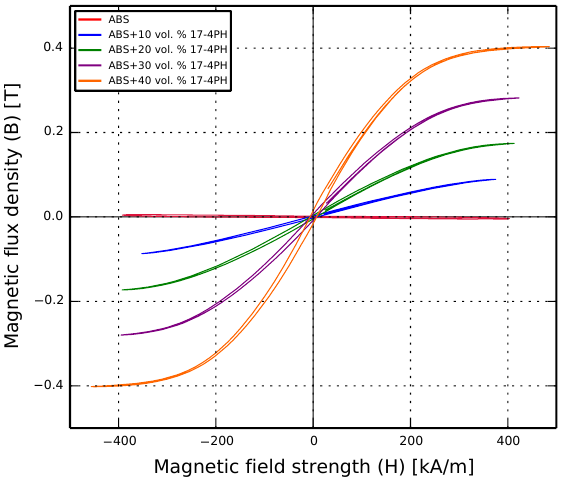
Figure 8. Results from the magnetic characterization of the composites, showing a maximum retentivity of 15.6mT for the 40vol. % sample. Table 4. Results from the magnetic